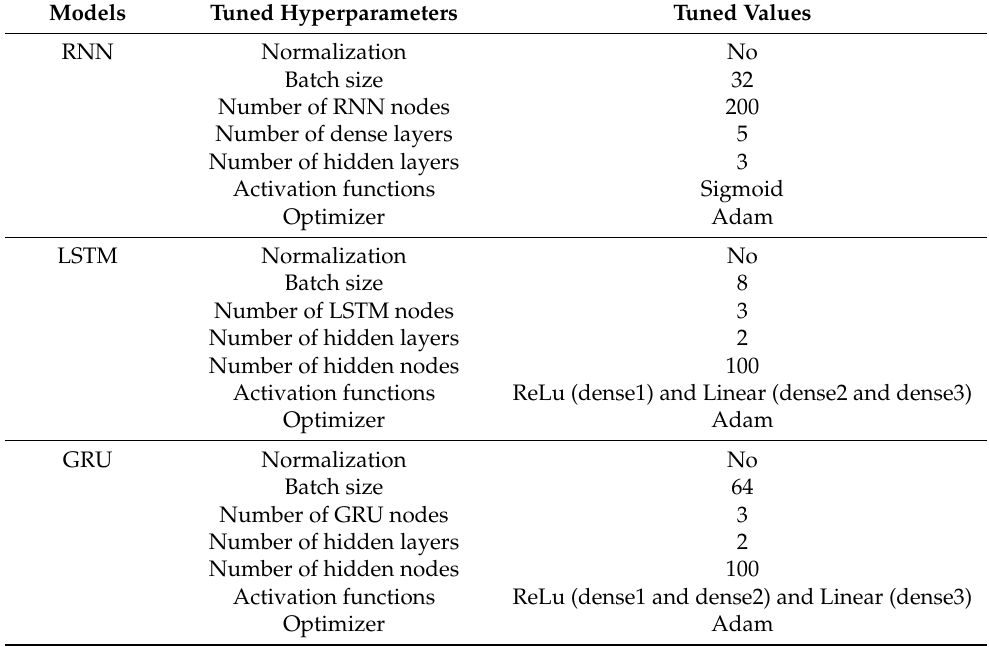
Table 6. Tuned hyperparameters that provide the best